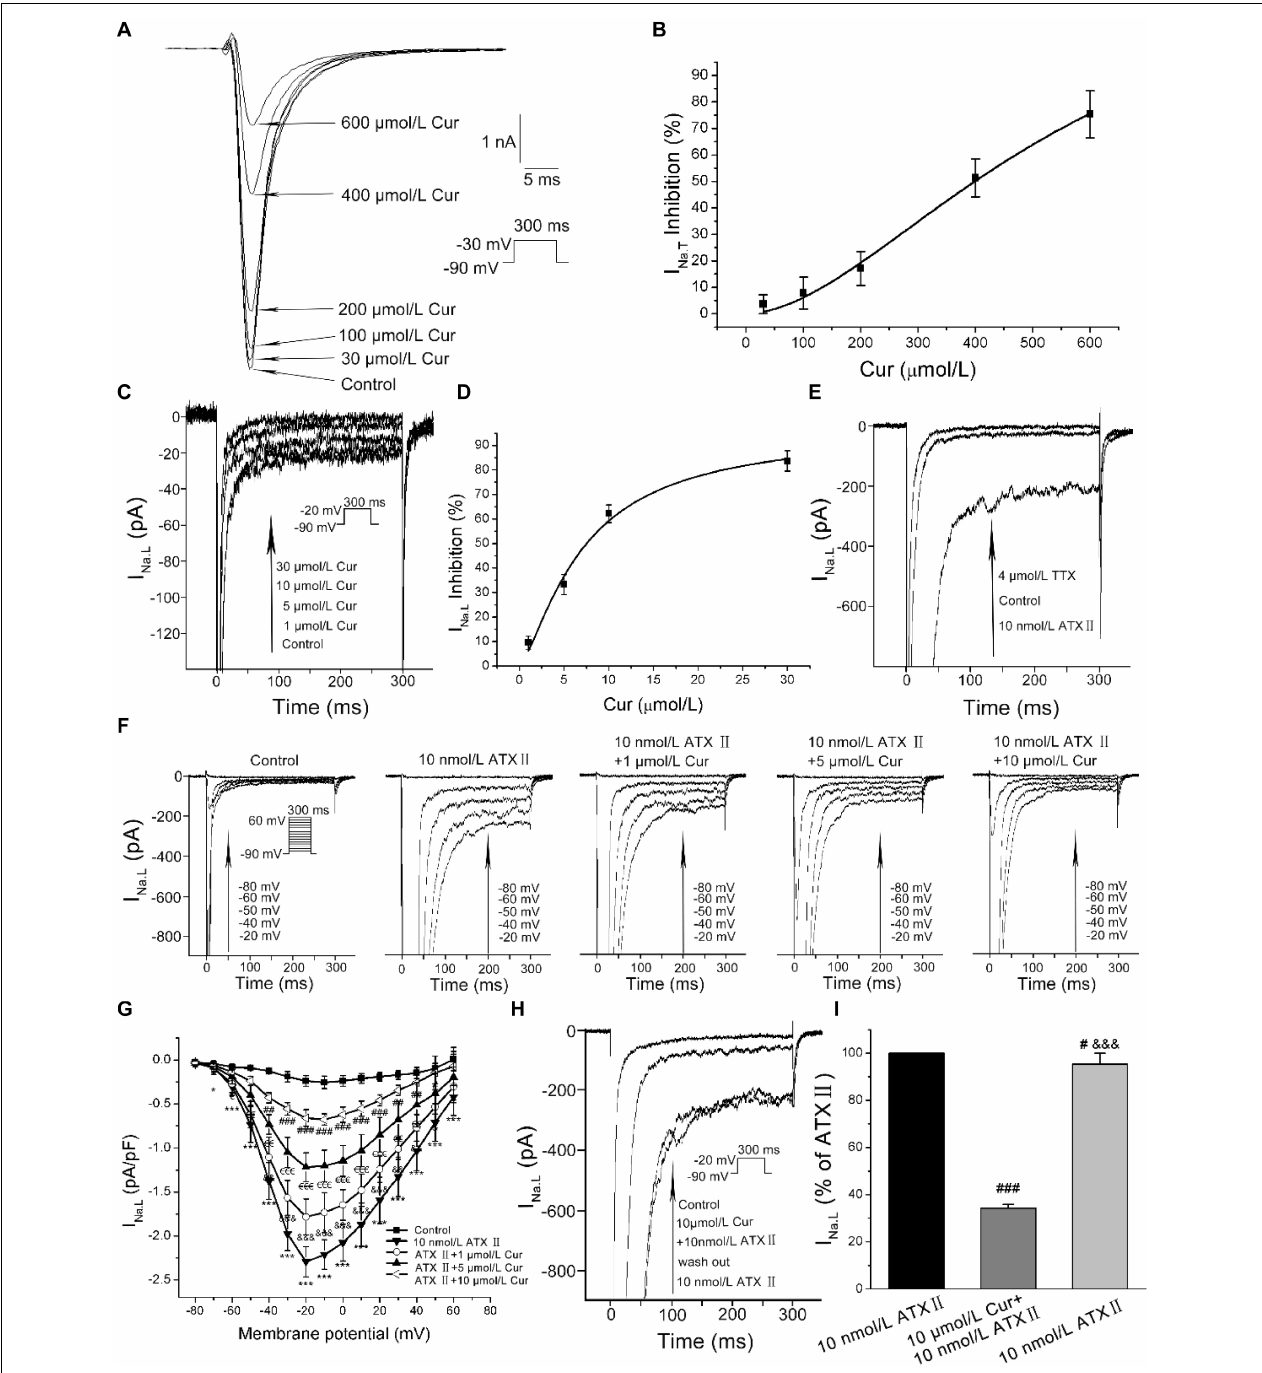
FIGURE 3 | The effects of Cur on transient sodium currents ( I Na . T ) and late sodium currents ( I Na . L ) in ventricular myocytes. (A) Example records of the single I Na . T of control group and Cur (30, 100, 200, 400, and 600 µ mol/L) groups. (B) The concentration–response relationship curve of Cur on I Na . T . (C) Example records of different concentrations of Cur on the basal endogenous I Na . L . (D) The concentration–response relationship curve of Cur on the single basal endogenous I Na . L . (E) Example records of I Na . L of control, ATX II, and TTX groups. (F) Example records of ATX II increased- I Na . L at membrane potentials of − 80, − 60, − 50, − 40, and − 20 mV from the same cell for the control group, ATX II group, and Cur groups (1, 5, and 10 µ mol/L). (G) The I – V relationships curves for the effects of Cur on ATX II-increased I Na . L ( n = 11, * P < 0.05, *** P < 0.001 vs. control; & P < 0.05, && P < 0.01, &&& P < 0.001 vs. 10 nmol/L ATX II; £ P < 0.05, ££ P < 0.01, £££ P < 0.001 vs. 1 µ mol/L Cur; # P < 0.05, ## P < 0.01, ### P < 0.001 vs. 5 µ mol/L Cur). (H) Example records of single I Na . L showing a reversible inhibitory effect of Cur on ATX II-increased I Na . L . (I) The comparison of average I Na . L percentage values of the three groups ( n = 8, # P < 0.05, ### P < 0.001 vs. control; &&& P < 0.001 vs. 10 µ mol/L Cur).